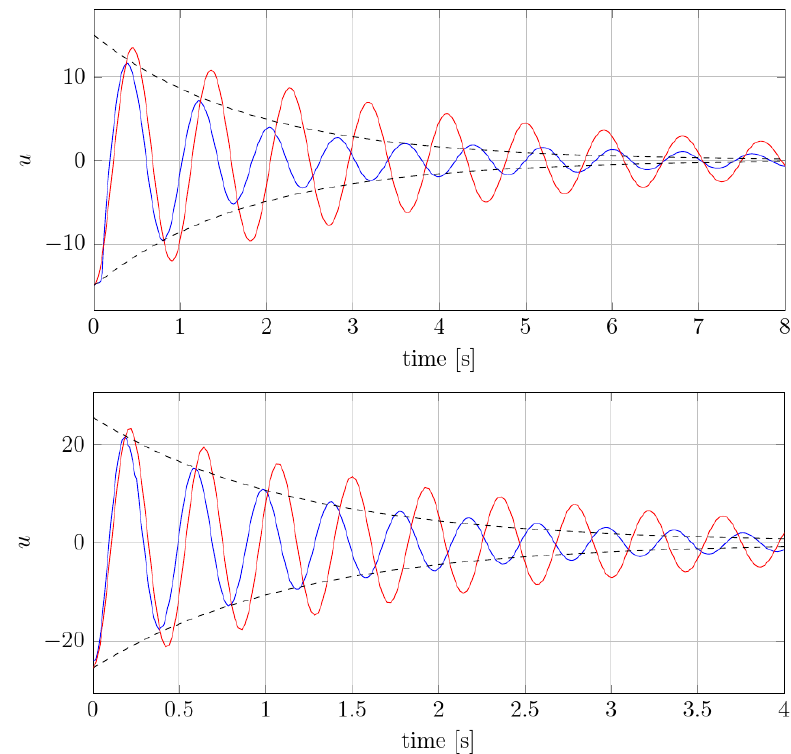
Figure 4. Modal acceleration of first ( top ) and second ( bottom ) vibration modes for the segmented model (blue) and monohull (red), compared to the decay based on experimental modal damping ratio (dashed line).